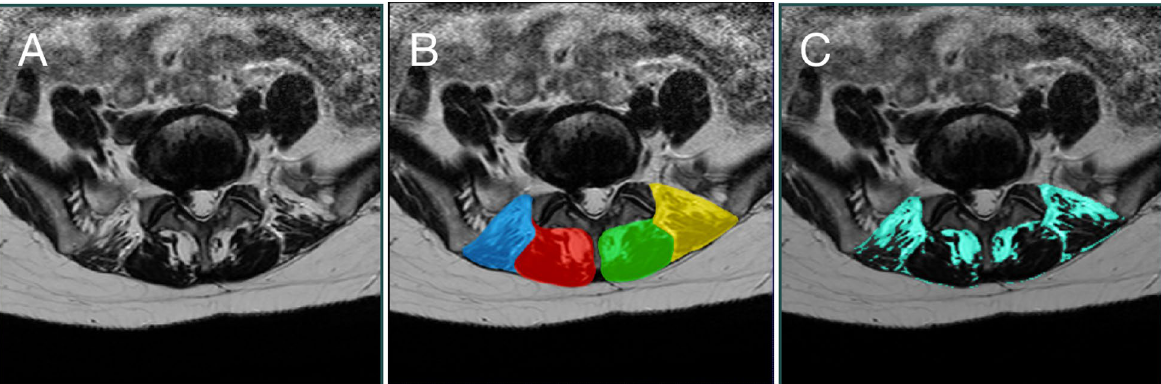
Figure 1. Demonstration of paraspinal muscle and fat tissue segmentation at the L5-S1 level. ( A ) Processed MRI, ( B ) manual segmentation of paraspinal muscles; ( C ) automatic fat tissue segmentation.